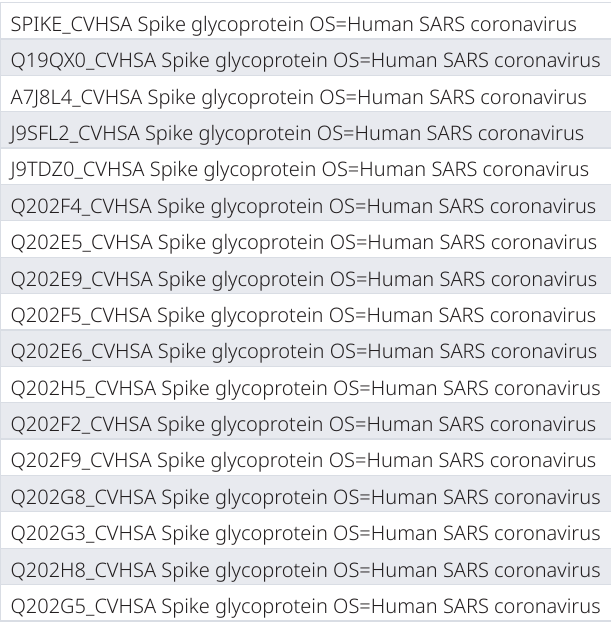
Table 1. S1 proteins from SARS_CoV (uniprot.org).